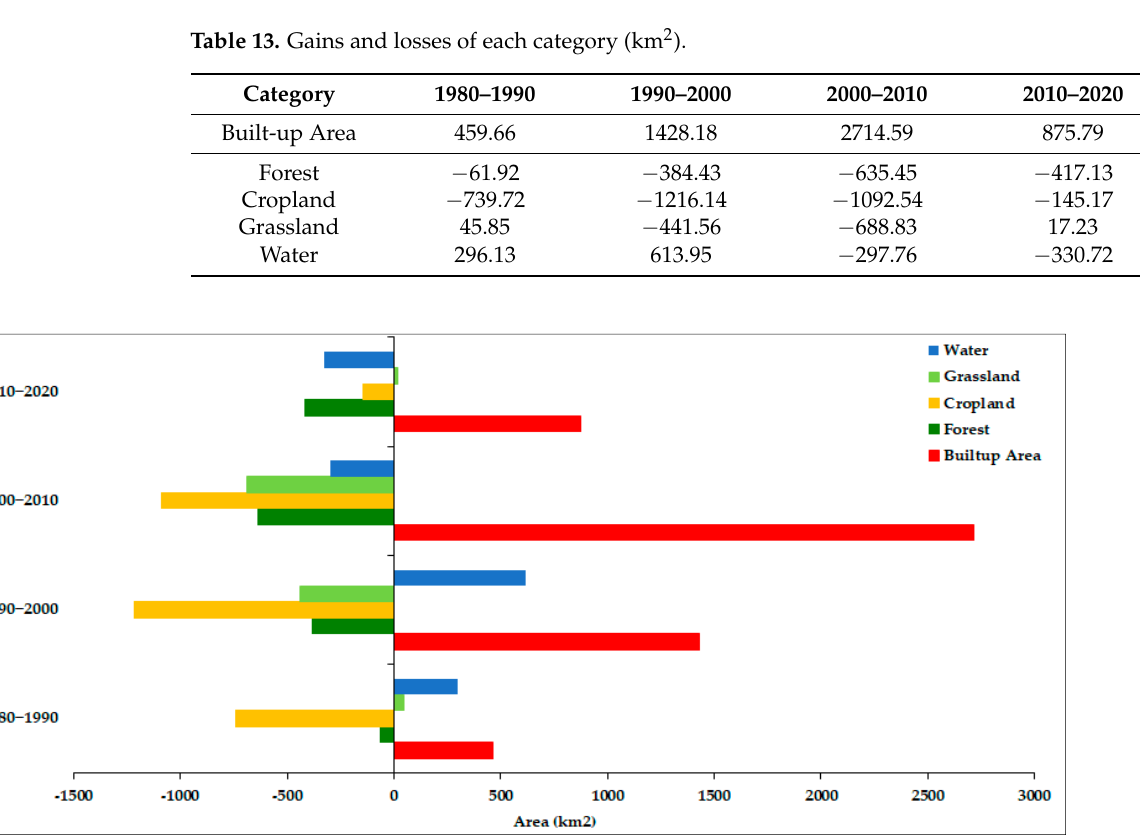
Figure 6. LULC Gains and Losses (1980–2020).